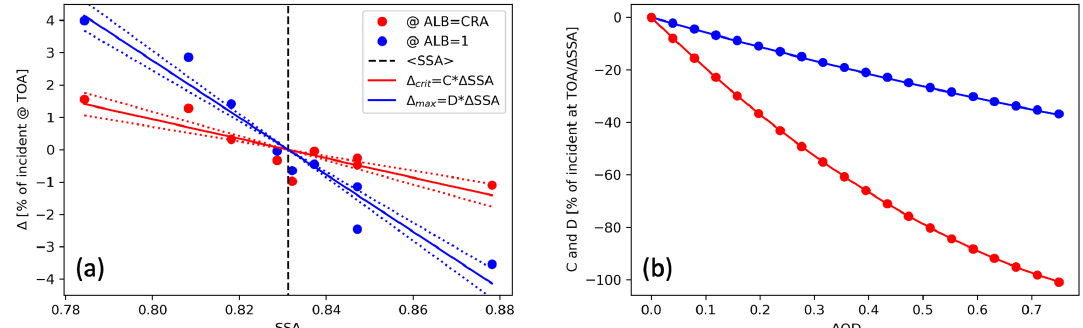
Figure 8. (a) DARE perturbations as a function of SSA at the case-average critical albedo (red) and at albedo = 1 (blue) for SZA = 20 ◦ . The vertical black dashed line indicates the case-average SSA. The dotted lines show the uncertainty in the C and D coefficients, which is propagated into the delta correction terms (Eqs. 22 and 23). (b) The dependence of the parameters C (red curve; determined at the critical albedo (Eq. 19) and D (blue curve; determined at albedo = 1 (Eq. 20) coefficients on mid-visible AOD.